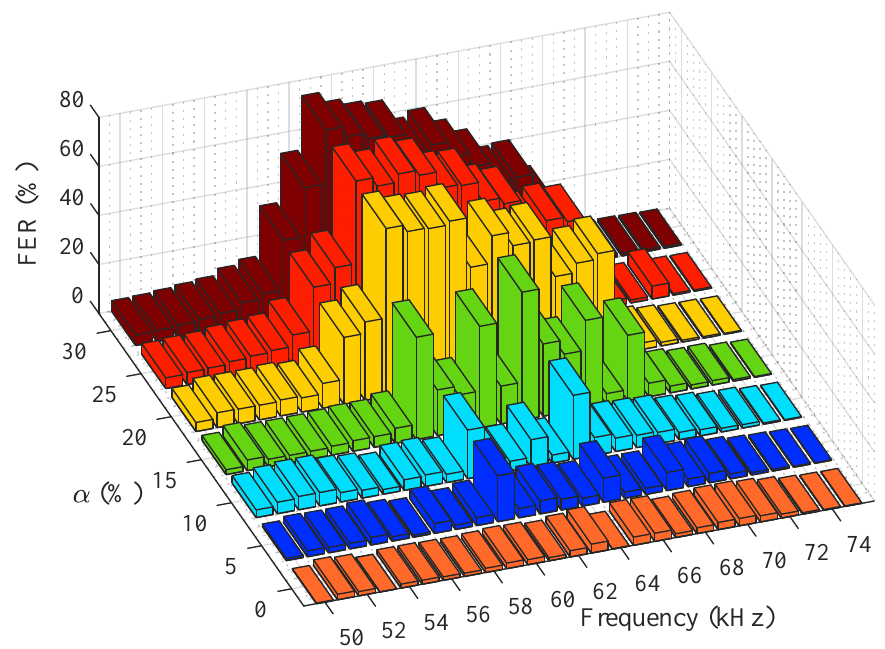
Figure 11. The PLC channel FER evaluation in the case of SSM EMI with several switching frequencies and spreading factors α .